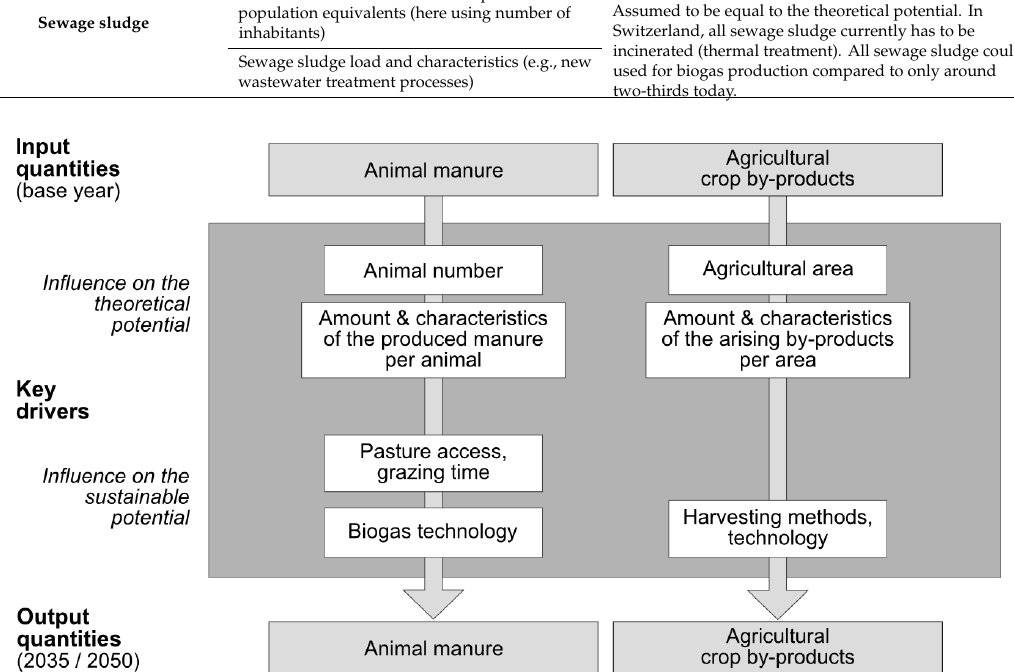
Figure 1. Key drivers for agricultural residues (animal manure and agricultural crop byproducts).